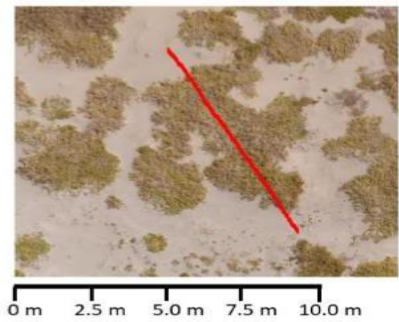
Figure 5. Location of the cross for the profile comparison with vegetation.